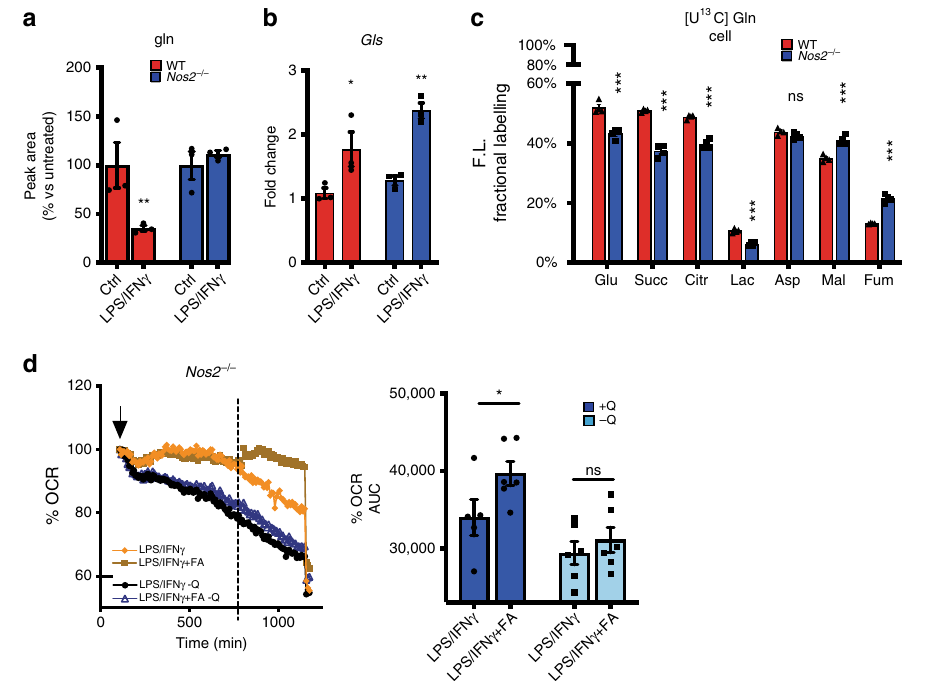
Fig. 5 LPS/IFN γ increase glutamine utilization in NO-dependent manner. a Extracellular glutamine levels were quanti fi ed by GC-MS in O.N. stimulated WT vs. Nos2 − / − . Data ( n = 9) were normalized to the absolute peak area of the metabolite in WT control and were analyzed by two-way ANOVA (interaction p = 0.0037) (Sidak ’ s post-tests). b RNA as in 2a were analyzed for Gls expression (two-way ANOVA with Sidak ’ s post-tests, p -values = 0.0114, 0.0024). c Fractional contribution of 13 C-labeling from [U- 13 C] Glutamine in metabolites of the TCA in activated WT vs. Nos2 − / − BMDMs Data ( n = 4) were analyzed by two-way ANOVA (interaction < 0.0001) (Sidak ’ s post-tests). d OCR in Nos2 − / − BMDMs after addition of LPS + IFN γ (at the arrow indicated) in the presence or absence of glutamine (Q). Bar graphs showing quanti fi cation of OCR after addition of FA compared to vehicle (dotted line). Data ( n = 3) were analyzed by two-way ANOVA (interaction p = 0.0192) (Sidak ’ s post-tests). All error bars display mean ± SEM. Source data are provided as a Source Data fi